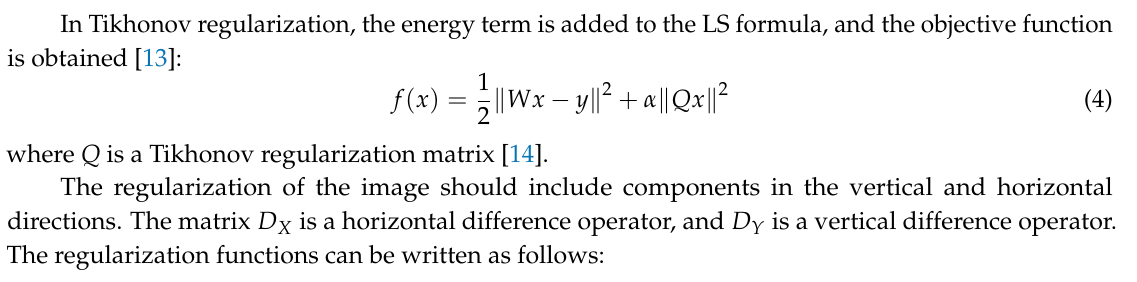
Figure 2. RTI sensor node deployment.